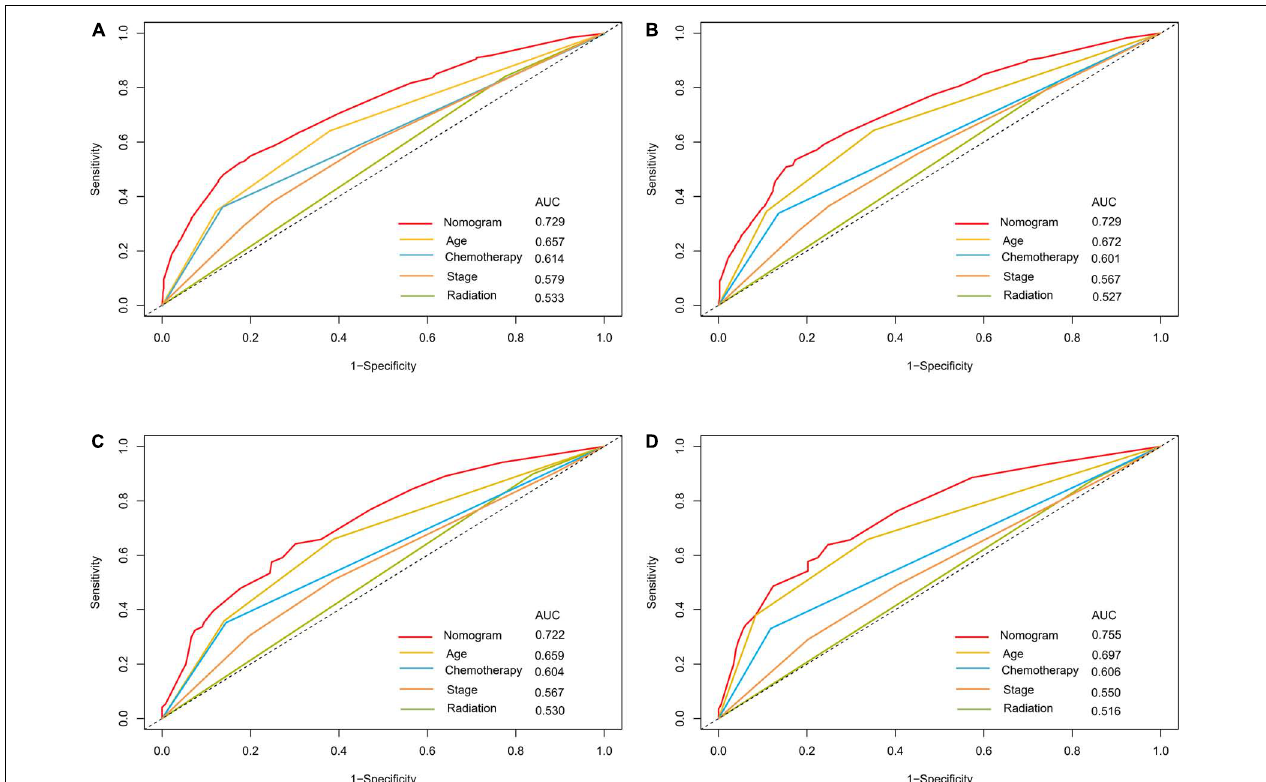
FIGURE 6 | ROC curves for predictions of overall survival in the development cohort (A,C) and validation cohort (B,D) at 3,